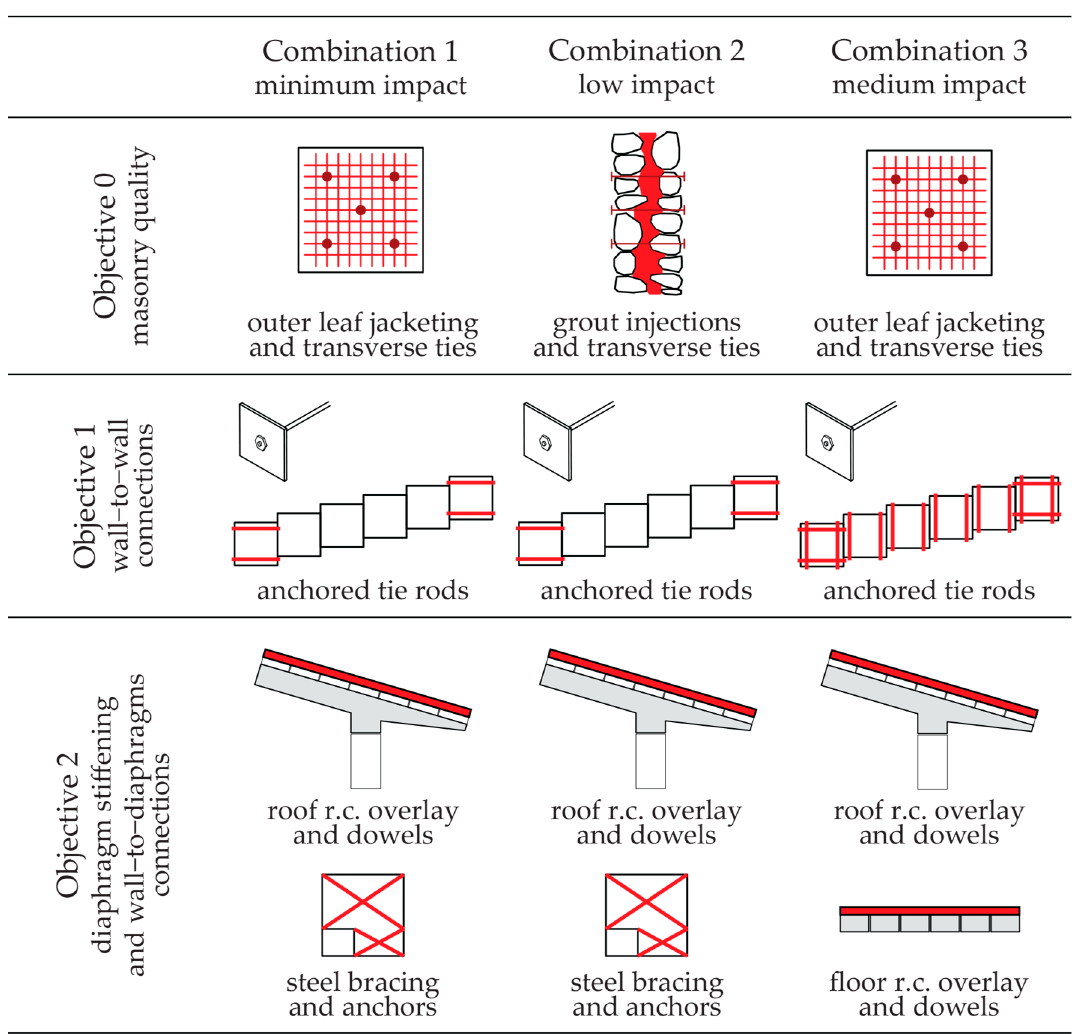
Figure 11. Summary of three combinations (i.e., strategies) of interventions proposed for IACP building.